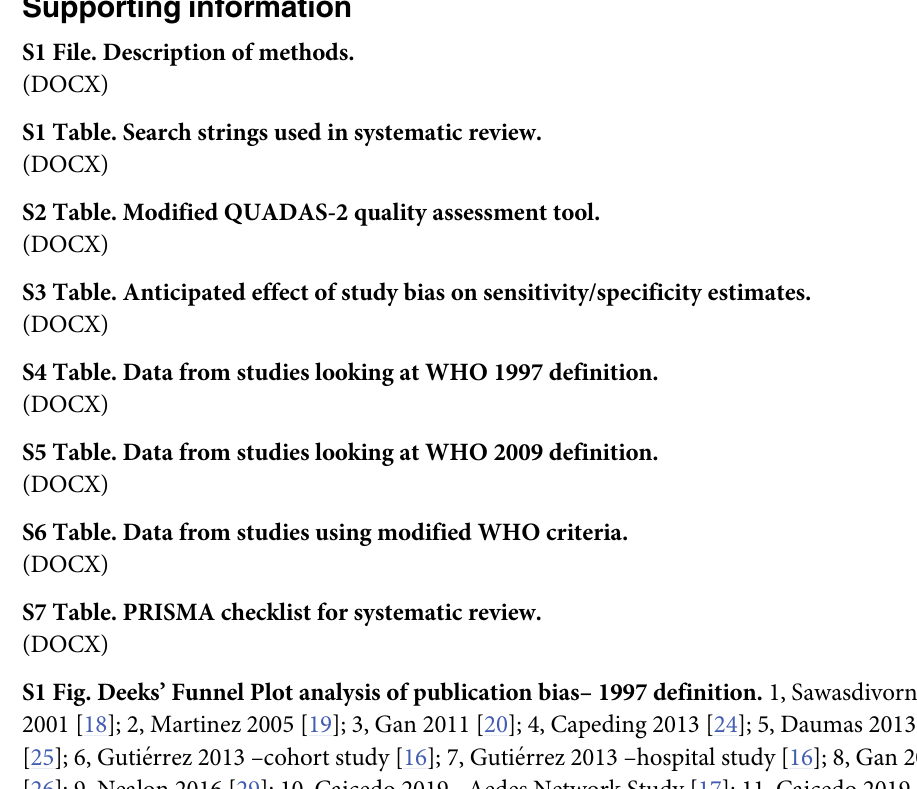
S2 Table. Modified QUADAS-2 quality assessment tool. S3 Table. Anticipated effect of study bias on sensitivity/specificity estimates. S4 Table. Data from studies looking at WHO 1997 definition. S5 Table. Data from studies looking at WHO 2009 definition. S6 Table. Data from studies using modified WHO criteria. S7 Table. PRISMA checklist for systematic